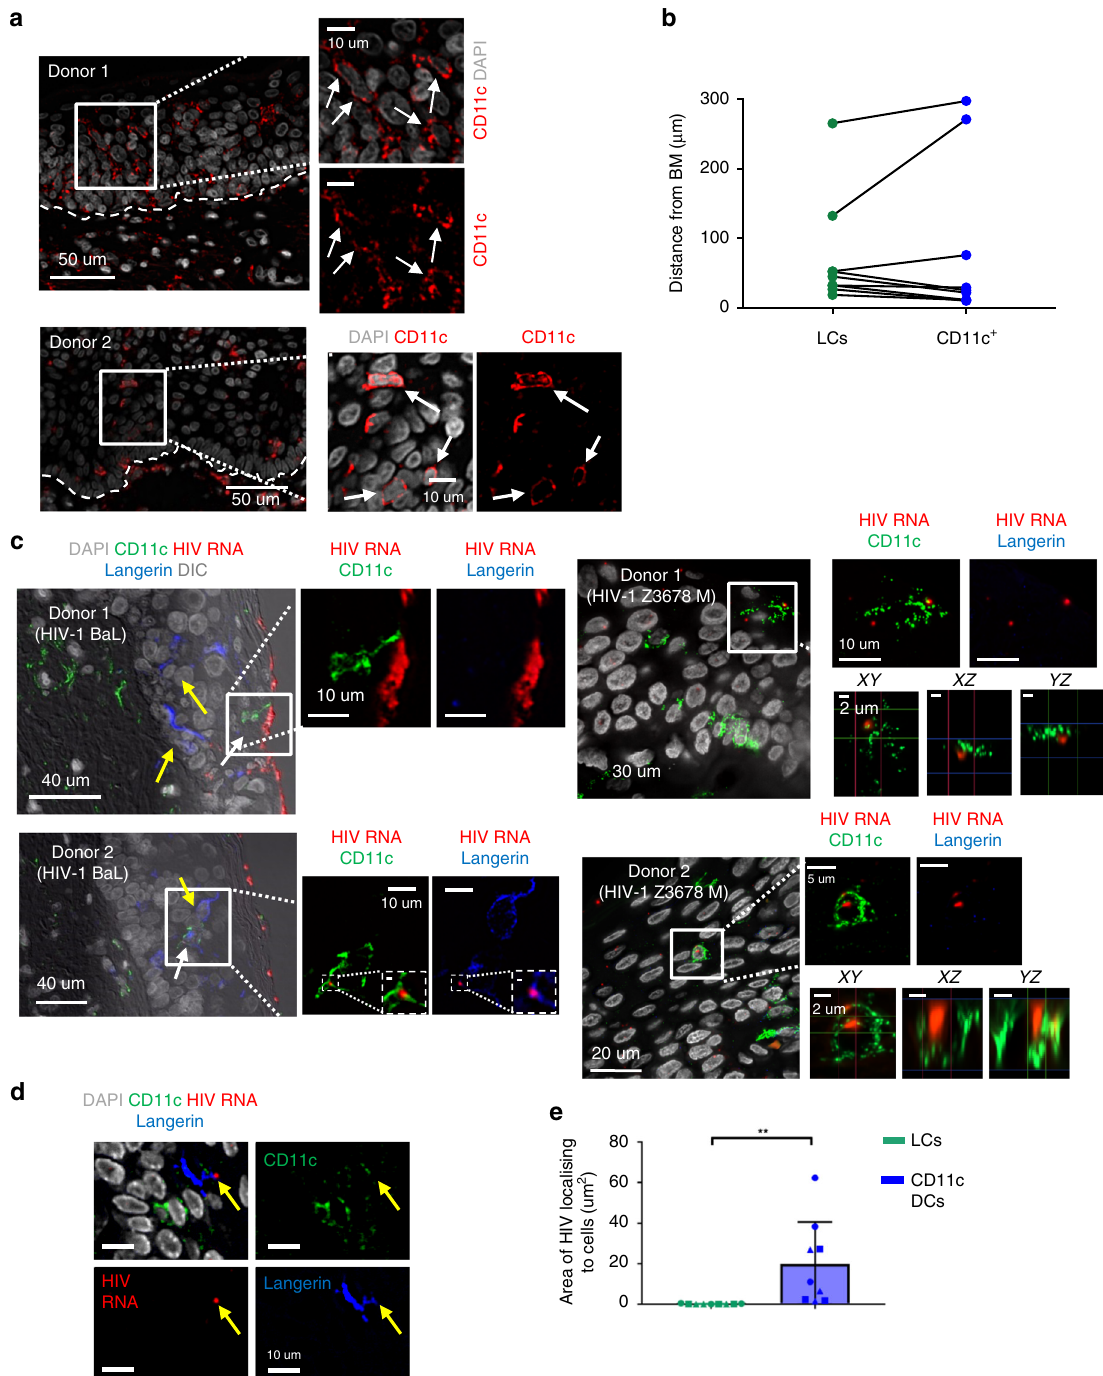
Fig. 6 Visualisation of anogenital CD11c + dendritic cells in situ and their interactions with HIV. Human foreskin explants were treated with lab-adapted HIV BaL or transmitted/founder HIV Z3678M or PBS (mock) for 2 – 3 h before being fi xed and paraf fi n embedded. The tissue was then sectioned and probed for HIV RNA using RNAscope coupled with immuno fl uorescent staining for CD11c and langerin. Epidermal CD11c + cells are shown with white arrows and LCs with yellow arrows. Representative images of 5 (HIV BaL ) or 3 (HIV Z3678M ) independent donors are shown (see Supplemental Fig. 3a for images from additional donors). a In healthy inner foreskin CD11c + cells were visualised throughout the epithelial layer. The broken line indicates the basement membrane. b In 10 donors we manually outlined LCs and epidermal CD11c + DCs and calculated their average distance from the basement membrane using the ‘ distance map ’ plug in ImageJ. c CD11c + DCs were observed interacting with HIV BaL and HIV Z3678M (top panels) at the epidermal surface or deeper in the epidermis containing HIV virions (bottom panels). For transmitted founder images Z- stacks were performed with 0.1 micron Z spacing and XY, XZ and YZ projections were generated. Scale bar on the dashed inset image is 1 um. d CD11c − langerin + Langerhans cells could also be detected containing HIV virions. e For donors infected with transmitted/founder HIV Z3678M , the area of HIV overlap with epidermal CD11c + cells and LCs was calculated by measuring the area of ‘ intersection ’ of each cell type with HIV. 3 sections were measured from three independent donors (nine sections in total). The total area of epidermis measured for each donor was between 23 – 43 mm 2 (54 – 102 × 20 fi elds) ( p = 0.0039) two-tailed Mann – Whitney